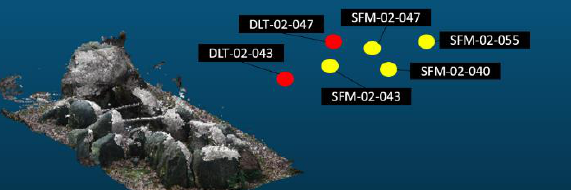
Figure 11: Camera orientations in relation to 3D model (red: DLT; yellow: